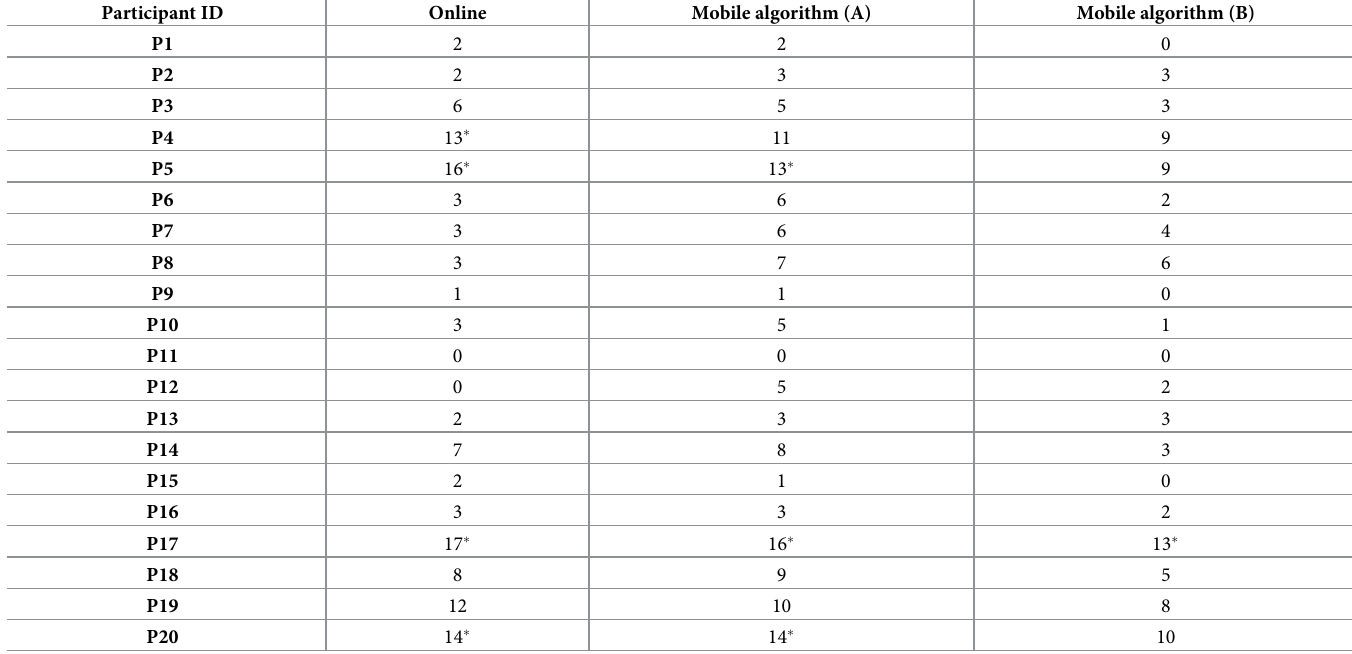
Table 1. List of all participants’ K-CESD-R scores. Asterisks ( (cid:3) ) indicate scores that met the cut-off criterion ( (cid:21) 13). Participant ID Online Mobile algorithm (A) Mobile algorithm